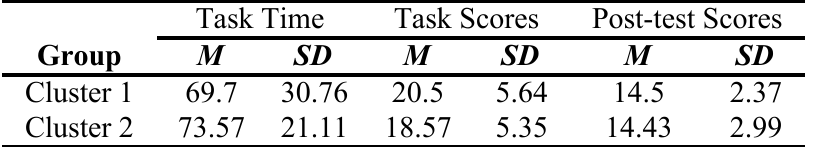
The Trends of Two Clusters for the